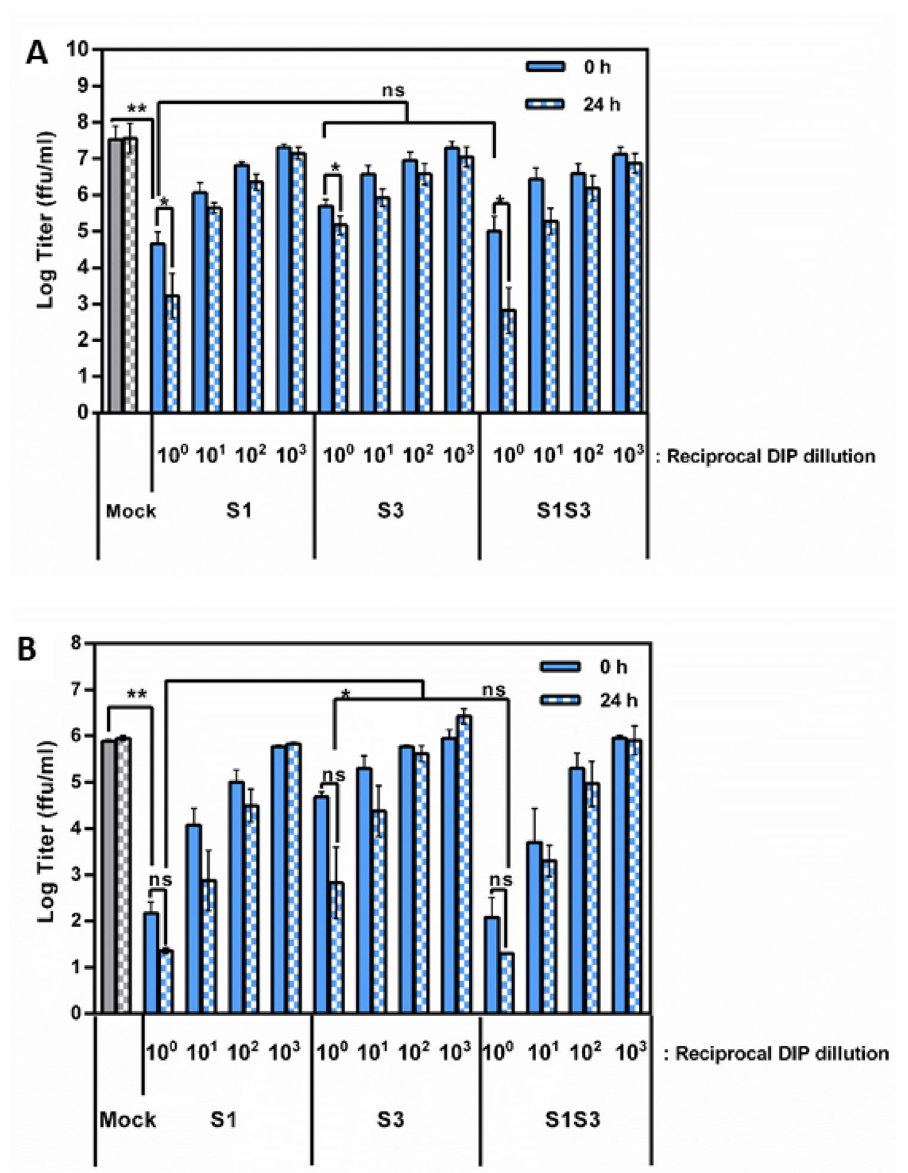
Figure 5. The presence of two DI RNAs does not increase antiviral activity. ( A ) MDCK cells were either co-inoculated with A/WSN/33 and the indicated DIPs at the indicated dilutions (solid bars) or cells were preincubated with DIPs for 24 h before virus was added (checkered bars). Infectivity was measured at 72 h post infection. The Log transformed average of five independent experiments is shown. Error bars indicate SEM. ( B ) The experiment was carried out as described for panel A but Calu-3 cells were used as targets. The log transformed average of three independent experiments is shown. Error bars indicate SEM. Two tailed paired student T-test was used to assess statistical significance. p < 0.5 = *, p < 0.05 = **, ns: not